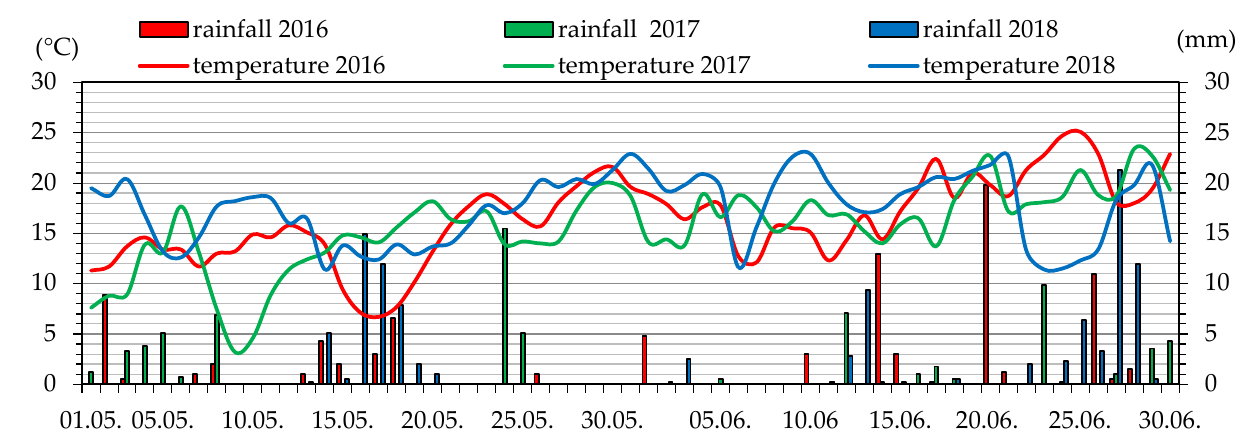
Figure 1. Average daily values of air temperature and precipitation in May and June 2016–2018 in Blinów II.